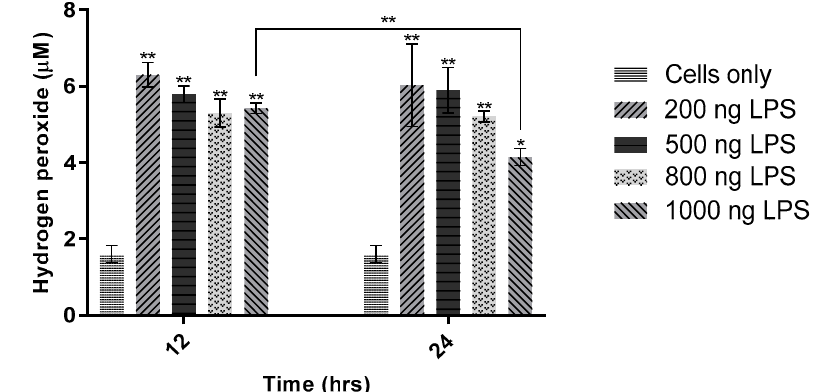
Figure 7. Effect of lipopolysaccharides concentration on hydrogen peroxide production in RAW 264.7 cells. Four concentrations of H 2 O 2 (200 ng/mL, 500 ng/mL, 800 ng/mL, and 1000 ng/mL) were added to cells in triplicate. Cells were incubated for 12 or 24 h. The sensitivity obtained was 4.10 pA/ µ M (R 2 = 0.9995). Data shown to correspond to Electrode 1 (E1), the microelectrode nearest the cells. One-way ANOVA ( n = 14, p < 0.001) and the Tukey–Kramer test ( n = 14, * p < 0.05, ** p < 0.001) were used to assess statistical significance.